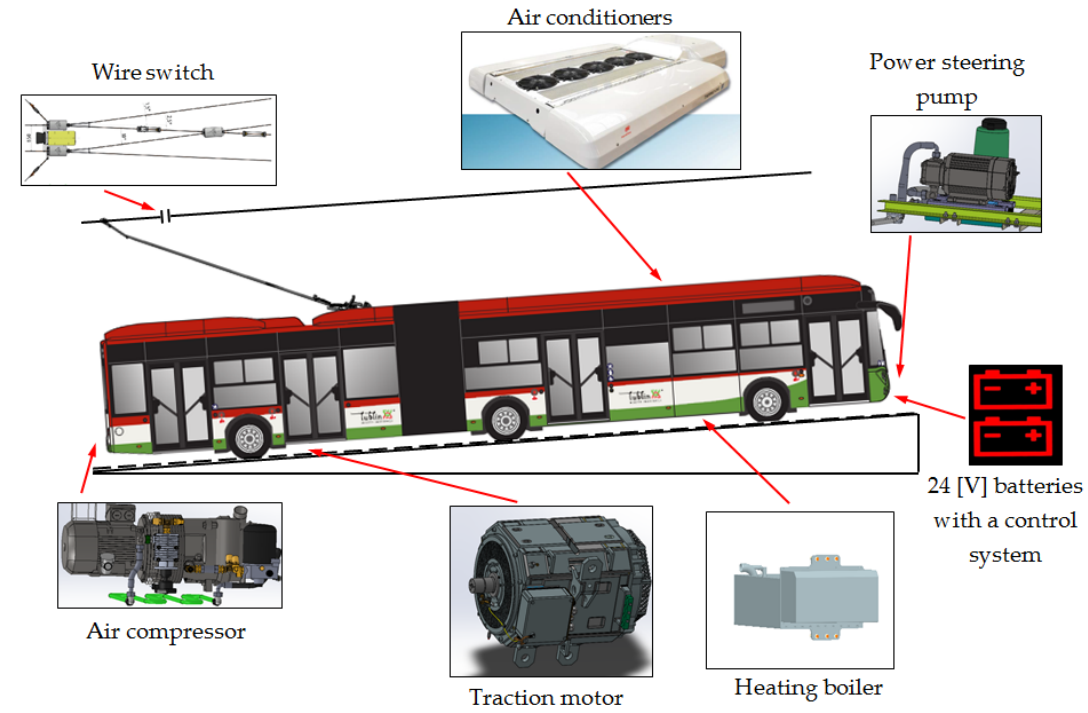
Figure 3. Components of trolleybus equipment; on-board auxiliary systems include air conditioners, 24 [V] batteries with a control system, a power steering pump, a heating boiler and an air compressor [21].